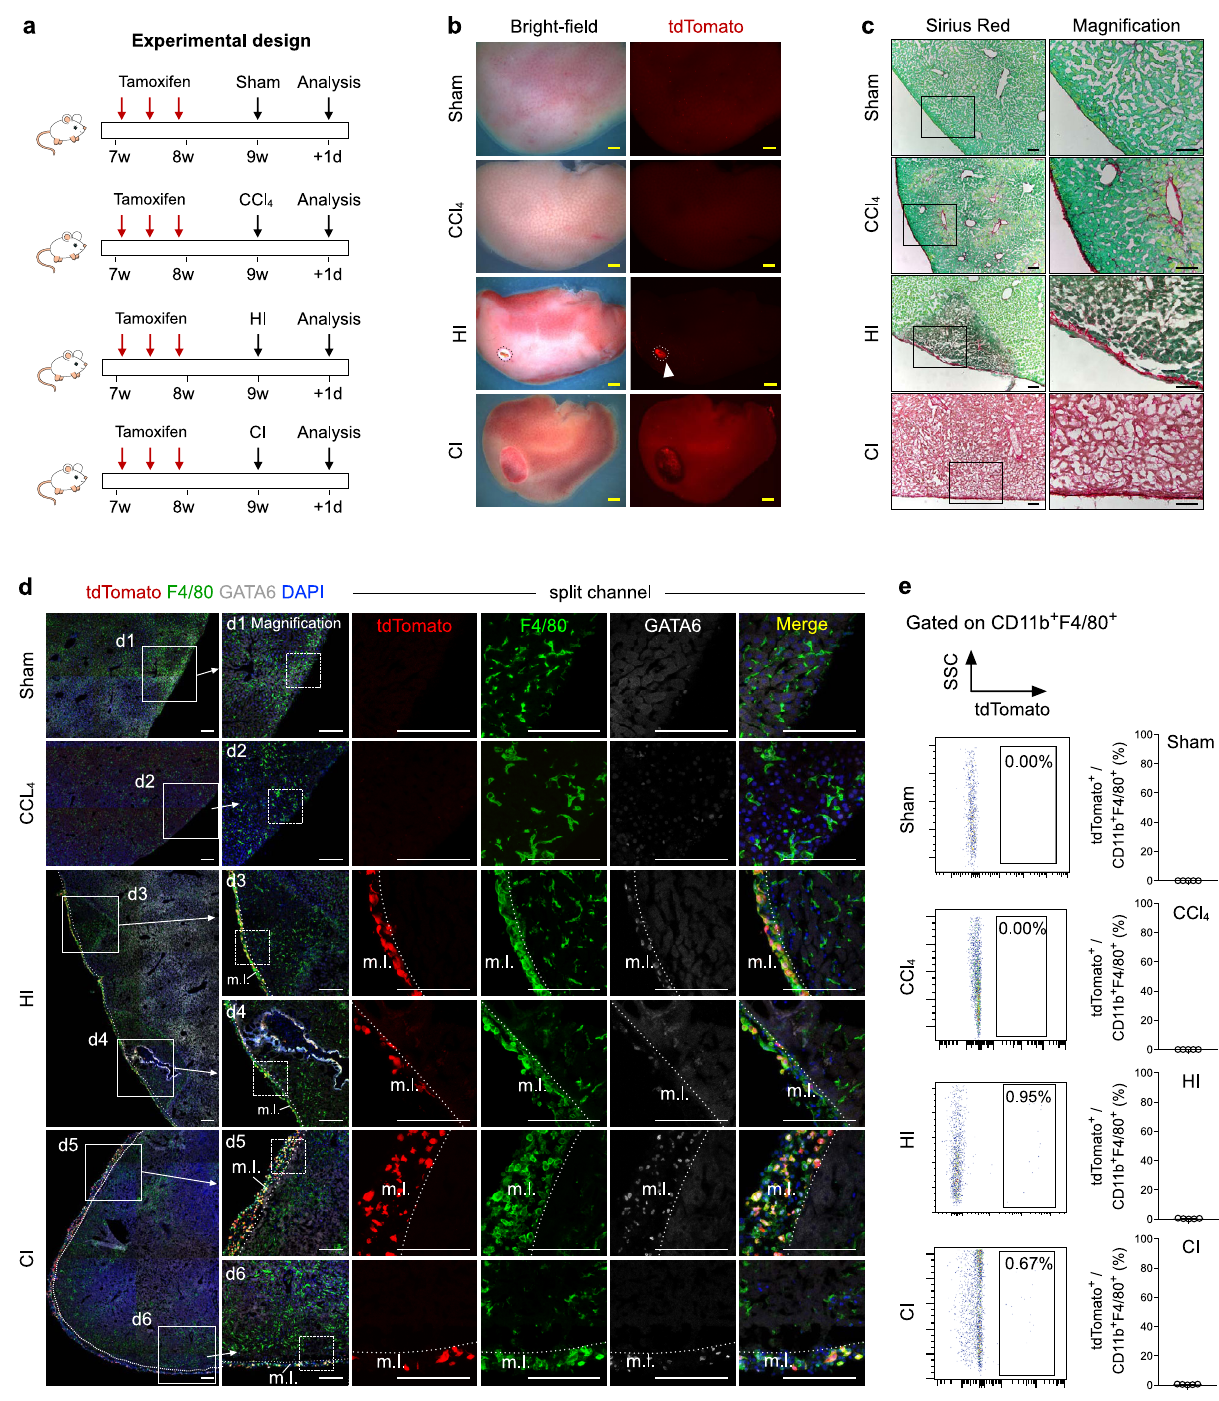
Fig. 2 Peritoneal macrophages do not invade deep into the liver parenchyma after CCl 4 , HI, or CI treatment. a Schematic fi gure showing experimental strategy. HI heat injury, CI cryoinjury. b Whole-mount bright- fi eld and fl uorescent images of livers with different injury models. Arrowheads, injury site. Scale bars, 1 mm. c Sirius red staining of liver tissue sections from livers treated with CCl 4 , CI, HI, or sham operation. Boxed regions are magni fi ed. Scale bars, 100 µ m. d Immunostaining for tdTomato, GATA6, and F4/80 on the injured region of the liver section. m.l., mesothelial layer. Boxed regions are magni fi ed. Scale bars, 100 µ m. e FACS analysis and quanti fi cation of the percentage of F4/80 + macrophages expression tdTomato. Data are the mean ± SD; n = 5 mice per group. Each image is representative of fi ve individual biological samples ( b – d ). Source data are provided as a Source Data fi le.